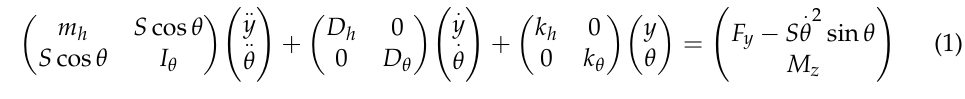
Table 1. List of the parameters involved in the equations of motion. Symbol